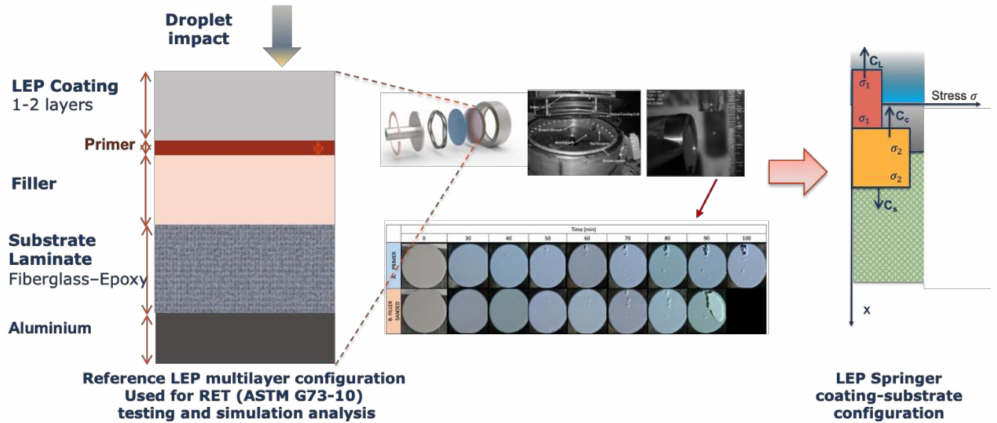
Figure 6. Reference multilayer configuration for rain erosion testing (RET) coupons (ASTM G73-10). Liquid droplet and each material layer are defined by the input mechanical parameters of Table 1. Table 1. Reference Input data used for the Lifetime Springer modelling in Case1. ASTM G73-10. Density Modulus E Speed of Material Layer Thickness ( µ (gr / cm 3 ) (Pa) Sound C (m / s)